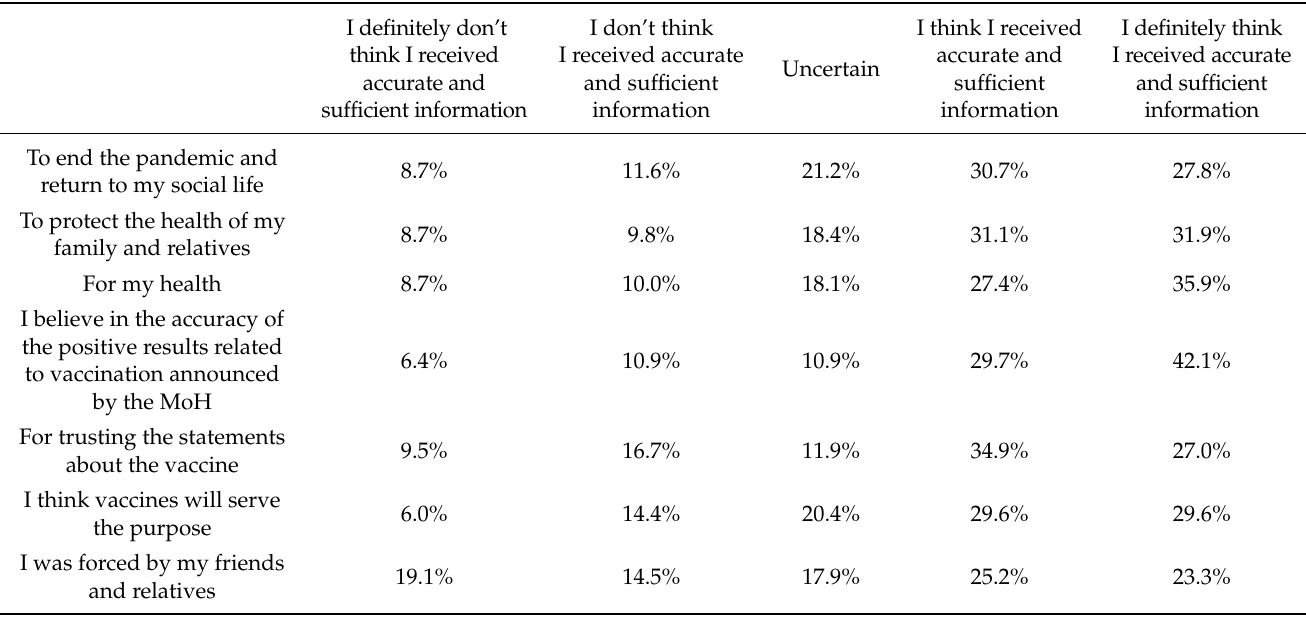
Table 4. The relationship between reasons for being vaccinated and receiving accurate and sufficient information about the